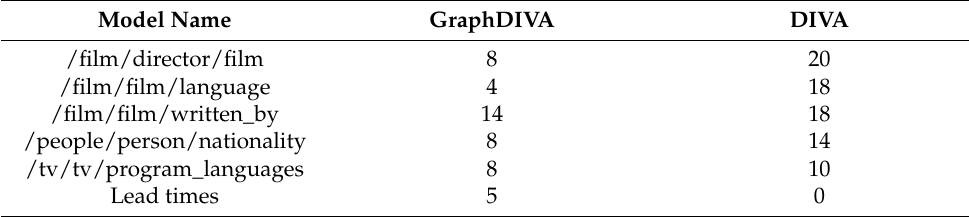
Table 6. Number of training sessions required to obtain the best results on FB15K-237.